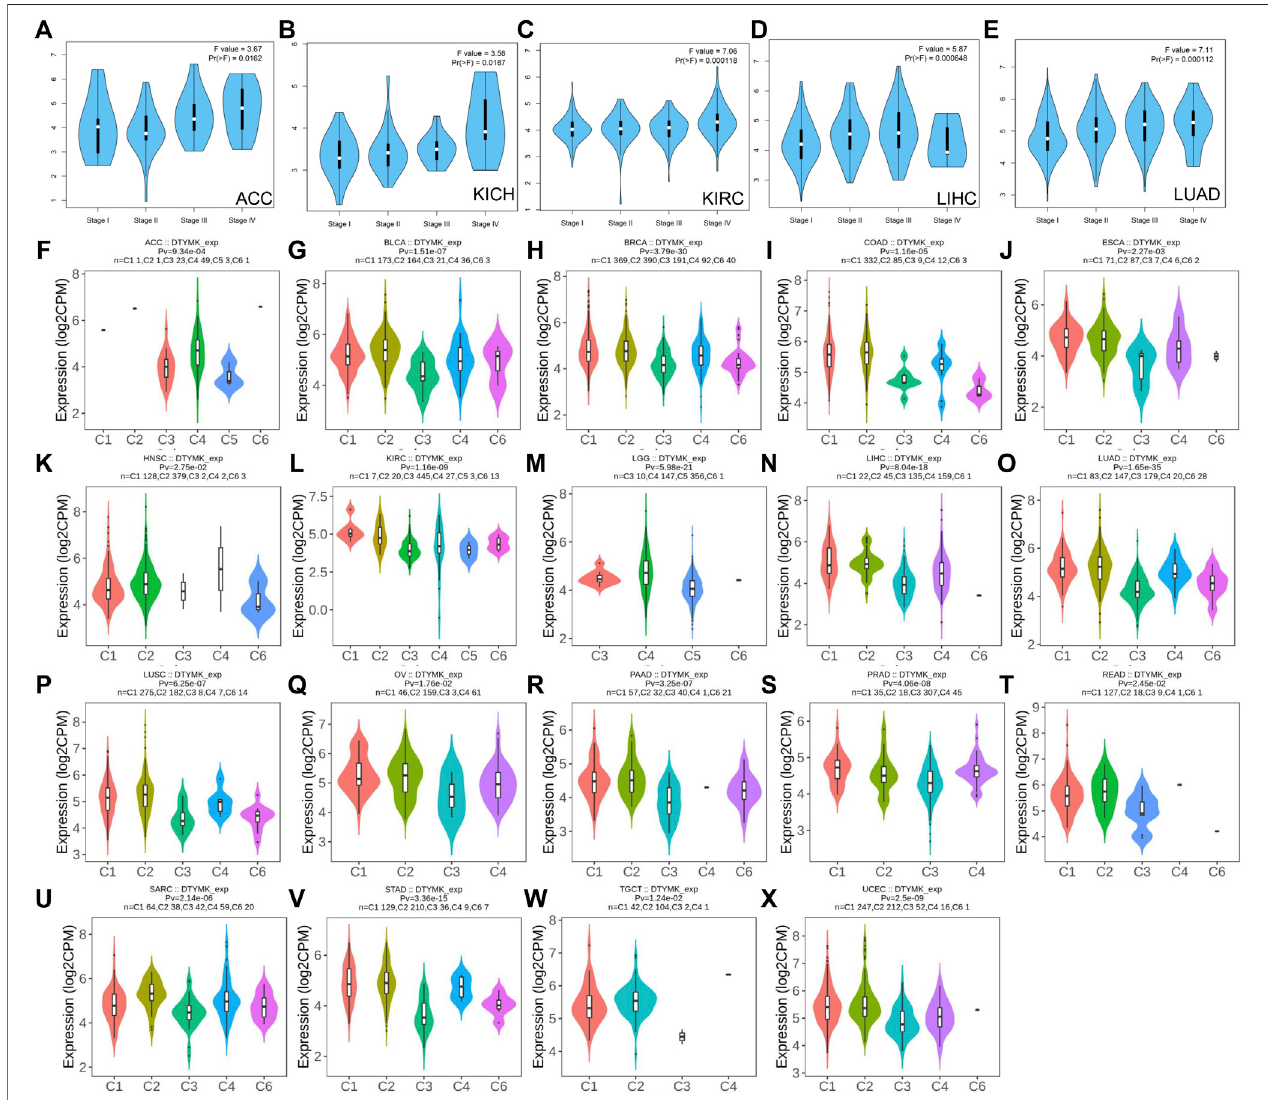
FIGURE 3 | DTYMK expression is discriminately distributed in different stages and immune subtypes of cancers. Variation of DTYMK expression was observed in stage I, II, III and IV of ACC (A) , KICH (B) , KIRC (C) , LIHC (D) and LUAD (E) using the GEPIA database. DTYMK expression in different immune subtypes of ACC (F) , BLCA (G) ,BRCA (H) ,COAD (I) ,ESCA (J) ,HNSC (K) ,KIRC (L) ,LGG (M) ,LIHC (N) , LUAD (O) , LUSC (P) ,OV (Q) ,PAAD (R) , PRAD (S) ,READ (T) ,SARC (U) ,STAD (V) , TGCT (W) and UCEC (X) . C1, wound healing; C2, IFN-gamma dominant; C3, in fl ammatory; C4, lymphocyte depleted; C5, immunologically quiet; C6, TGF- β dominant.ACC,Adrenocorticalcarcinoma;BLCA,Bladder urothelialcarcinoma;BRCA,Breastinvasivecarcinoma;COAD,Colonadenocarcinoma;ESCA, Esophageal carcinoma; HNSC, Head and neck squamous cell carcinoma; KIRC, Kidney renal clear cell carcinoma; LGG, Brain lower grade glioma; LIHC, Liver hepatocellular carcinoma; LUAD, Lung adenocarcinoma; LUSC, Lung squamous cell carcinoma; OV, Ovarian serous cystadenocarcinoma; PAAD, Pancreatic adenocarcinoma; PRAD, Prostate adenocarcinoma; READ, Rectum adenocarcinoma; SARC, Sarcoma; STAD, Stomach adenocarcinoma; TGCT, Testicular germ cell tumors; UCEC, Uterine corpus endometrial